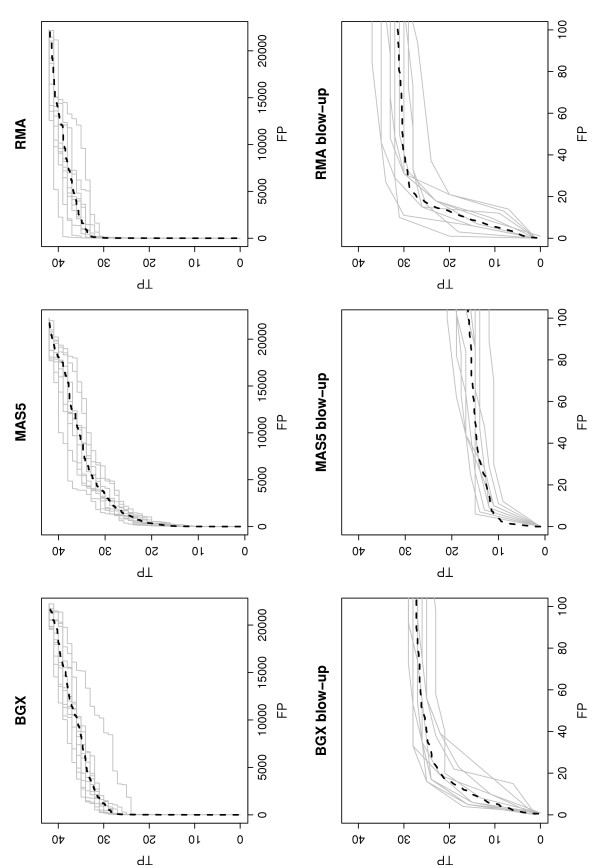
ROC curves for one versus one comparisons of arrays from the AffyU133A data set obtained with different methods. (see legend of Figure2).